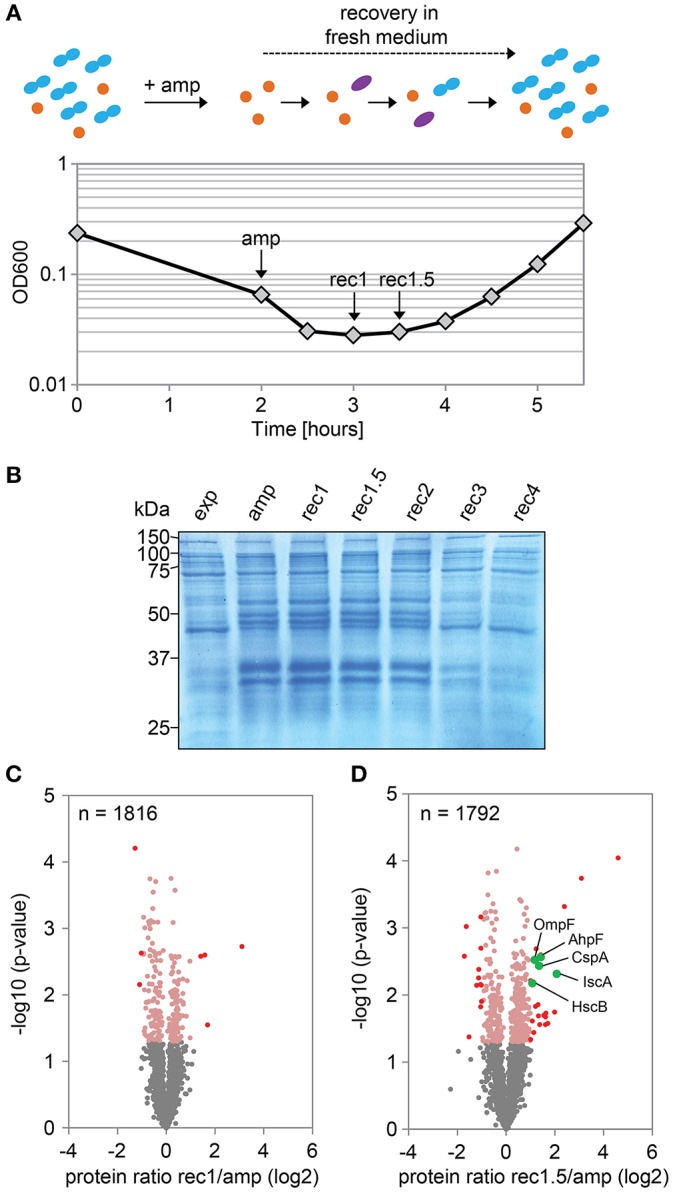
Proteome analysis of persister cells during recovery from ampicillin treatment. (A) Graphical illustration of a persister cycle experiment with the highly persistent strain Δ1-41 ΔistR. Actively growing cells are blue, persisters are orange, and cells in the process of recovery are purple. Treatment with ampicillin (amp) during exponential growth phase leads to rapid lysis of non-persistent cells. After transfer of surviving persisters into recovery medium, cells eventually awake and resume growth. A representative growth curve is shown and time points for mass spectrometry analysis are indicated. (B) SDS-PAGE of protein samples from persister cycle experiments. Proteins (total amount of 50 μg per sample) were separated on 12% polyacrylamide gels and stained with colloidal Coomassie. A size marker (in kDa) is given on the left hand side. (C,D) Volcano plots for the comparison between recovery samples and ampicillin treatment. Data are derived from mass spectrometry analysis. Proteins with a significant change in abundance after 1 h (B) and 1.5 h (C) of recovery are in red (log2 ratios >1 or < −1, P < 0.05). Pink dots: log2 ratios <1 or >-1, P < 0.05. Gray dots: log2 ratios <1 or >-1, P > 0.05. Exp: exponential phase; amp: 2 h ampicillin treatment; rec1: 1 h recovery; rec1.5: 1.5 h recovery; rec2: 2 h recovery; rec3: 3 h recovery; rec4: 4 h recovery.